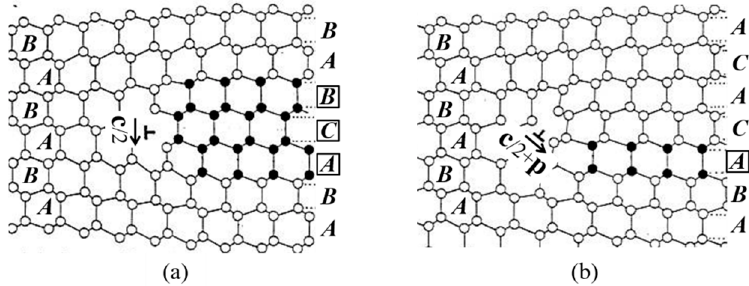
Figure 3. Sessile partial dislocations. ( a ) Frank partial dislocation with Burgers vector < c / 2 > associated with three bilayers of cubic sequence B , C , and A . ( b ) Frank–Shockley partial dislocation with Burgers vector < c / 2 + p > associated with mono-bilayer of cubic sequence A [4,8].